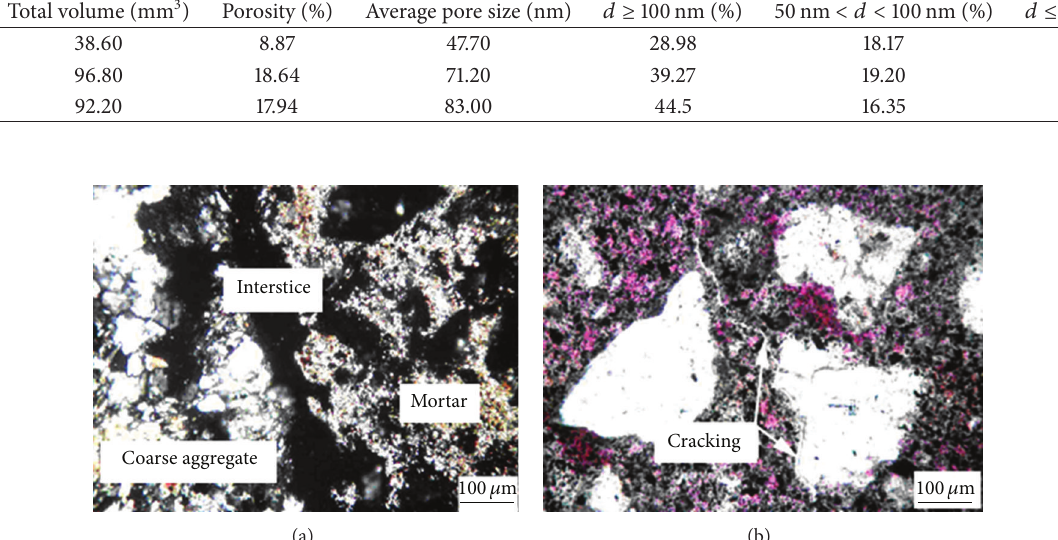
Figure 6: Photos of microstructure (a) interstice between coarse aggregate and mortar and (b) cracking in the mortar.